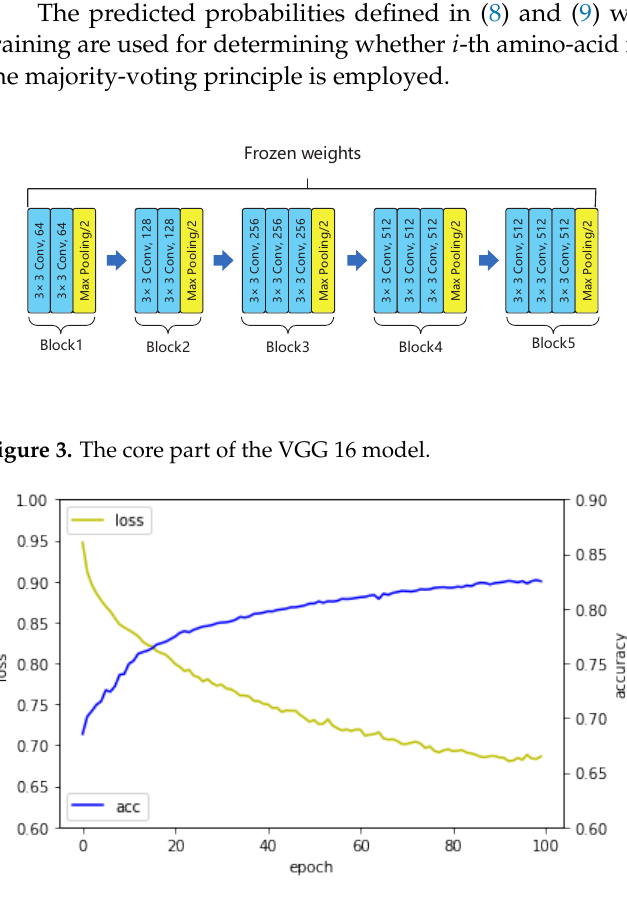
Figure 4. The learning curve of the